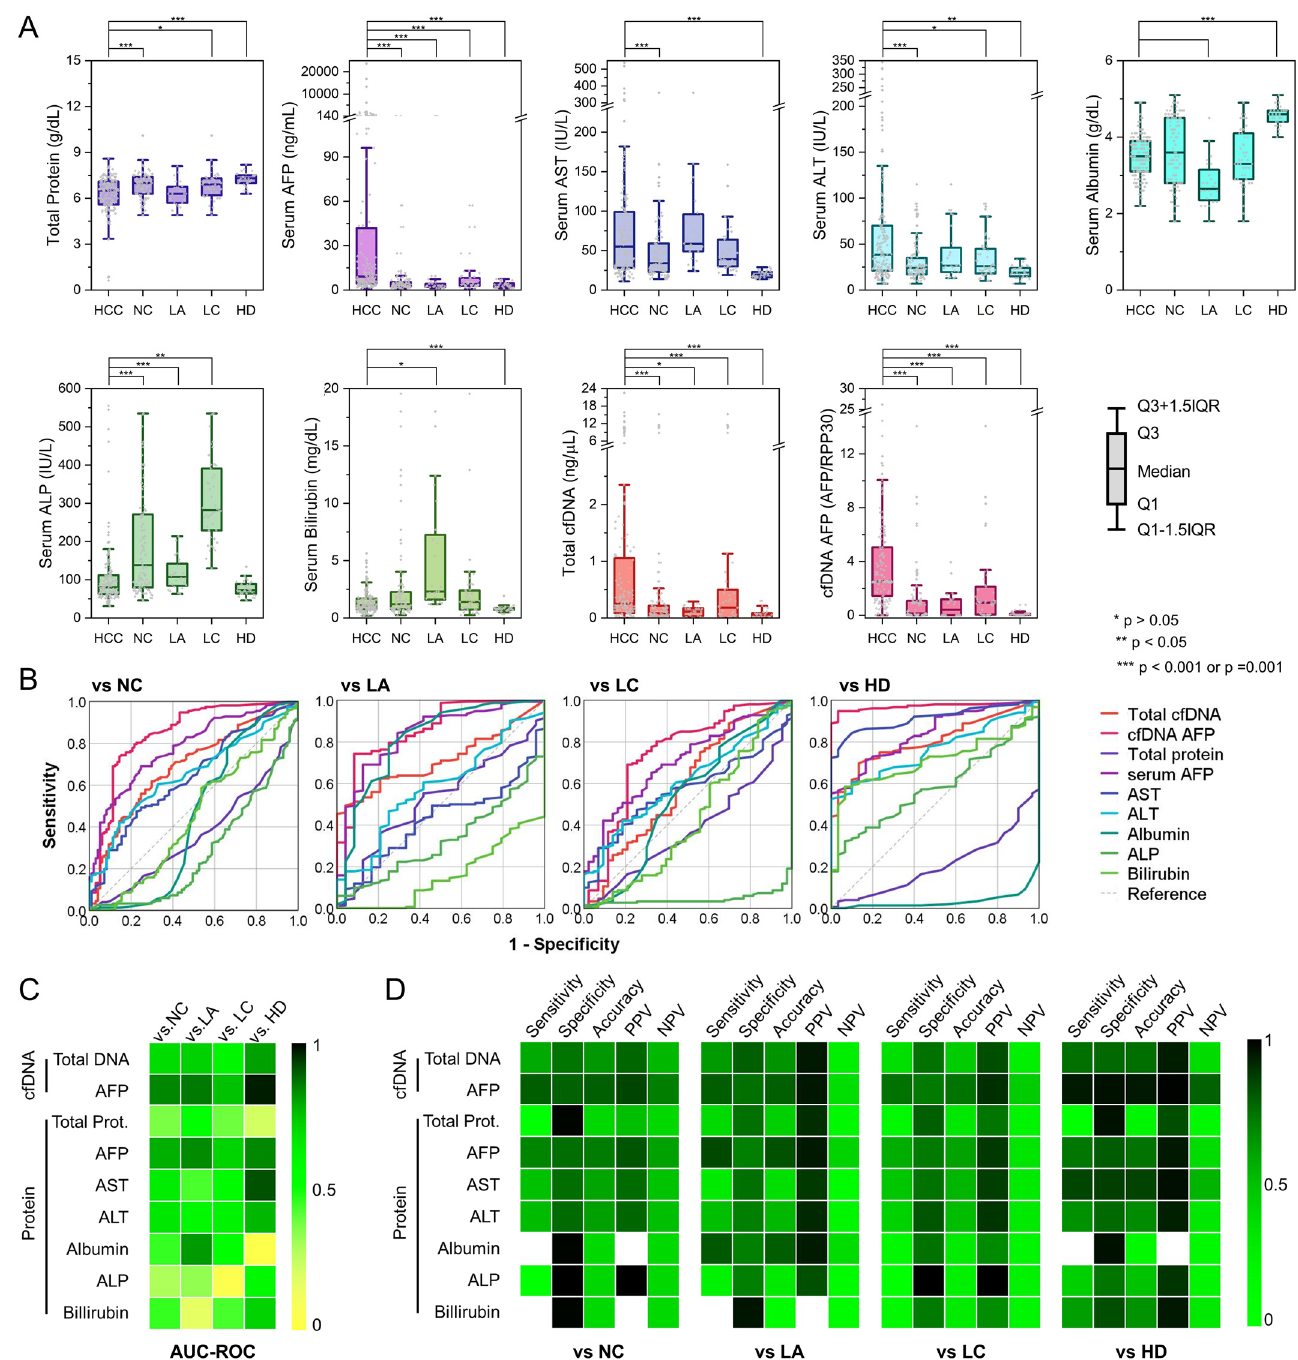
Figure 2. The diagnostic capability of cfDNA for detecting HCC patients from non-cancer (NC) cohorts: ( A ) the expression profiles of serum enzymes, plasma cfDNA, and cfAFP-DNA quantified from a total of 152 HCC patients and 97 non-cancer cohorts, which include 43 patients diagnosed with liver cirrhosis (LC), 24 patients diagnosed with alcoholic liver hepatitis (LA), and 30 healthy donors (HD). ( B , C ) ROC curves for diagnosing HCC from NC, LC, LA, and HDs using the expression profiles of serum enzymes, plasma cfDNA, and cfAFP-DNA. ( D ) Diagnostic performance of serum enzymes, plasma cfDNA, and cfAFP-DNA for detecting HCC patients.